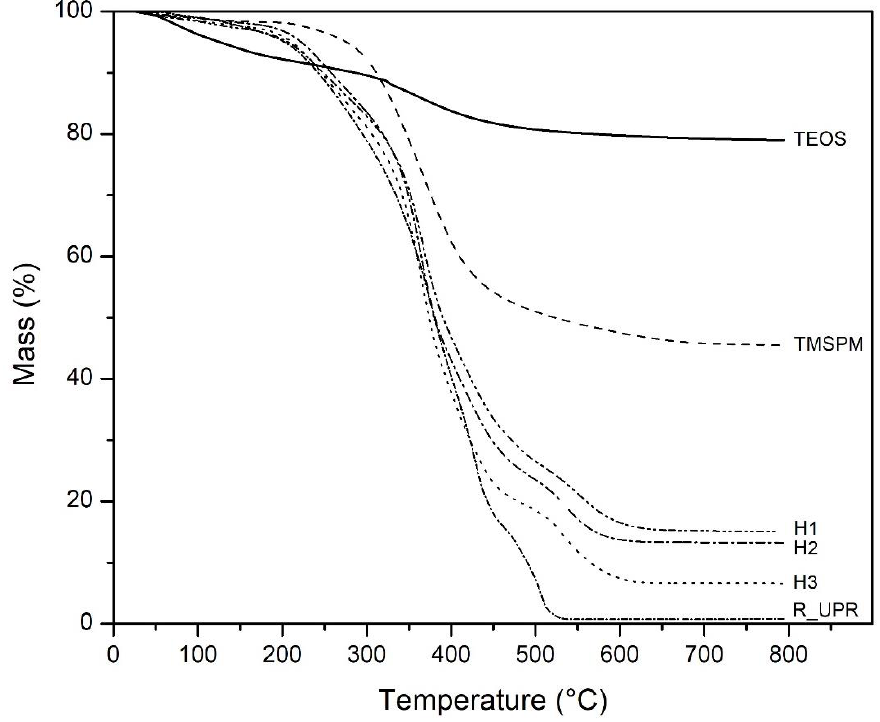
Figure 3. Thermogravimetric analysis of precursor materials TEOS, TMSPM, and R-UPR.